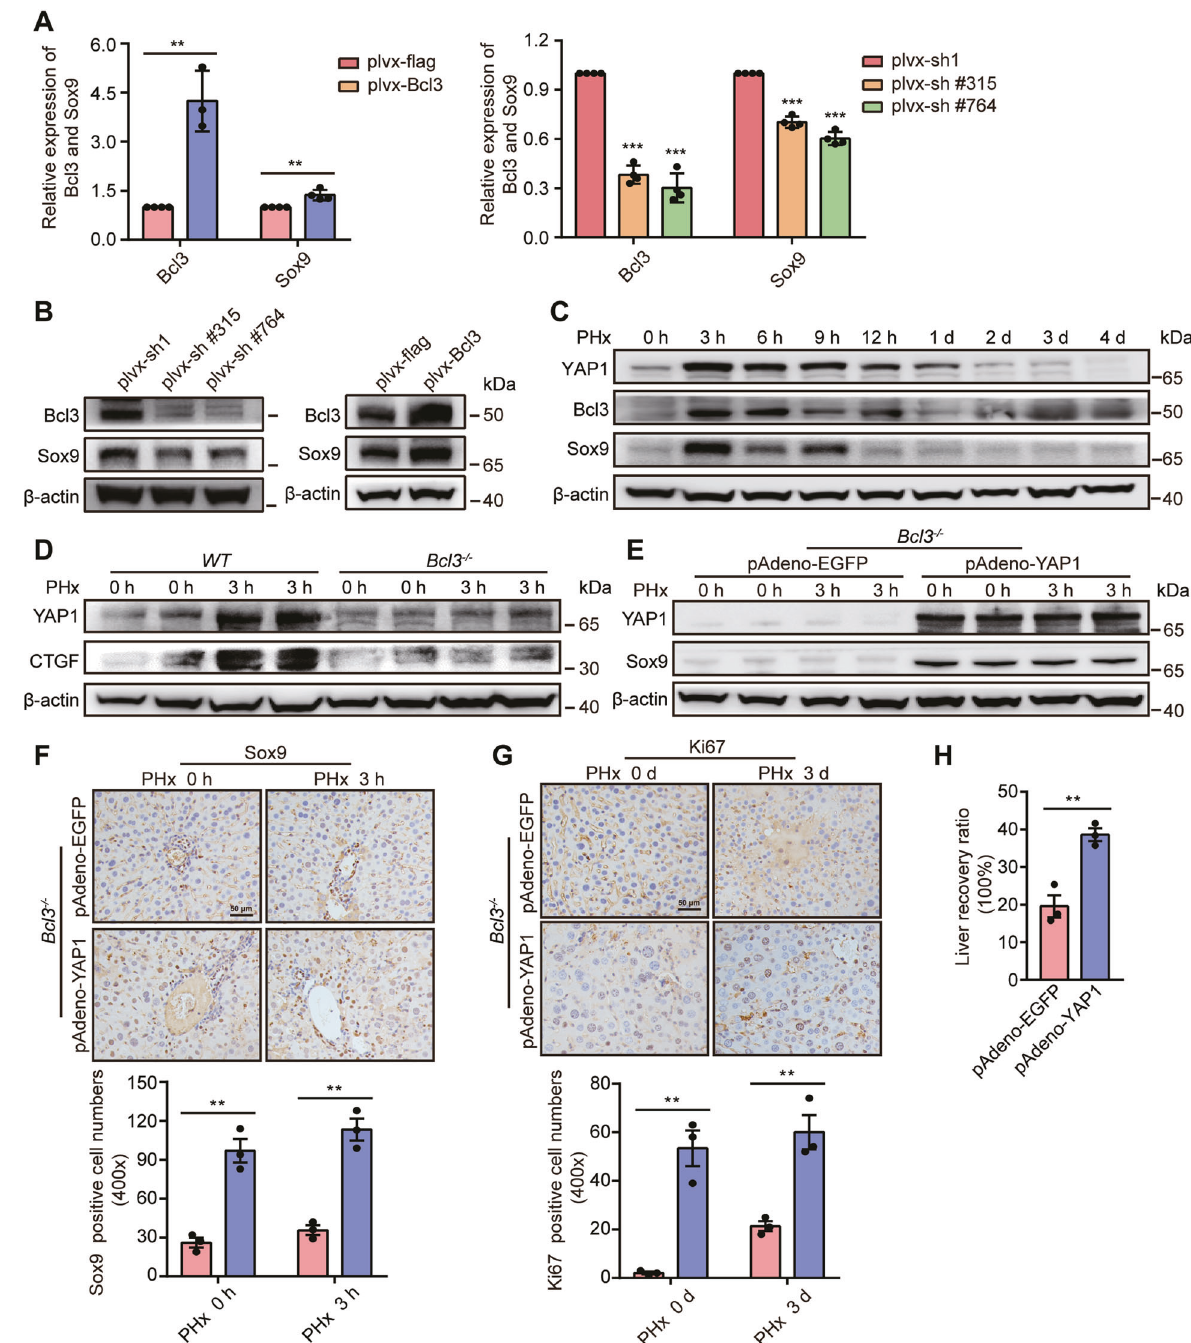
Fig. 4 YAP1 functions as a downstream target of Bcl3 to participate in liver regeneration. A , B qRT-PCR ( A ) and western blotting analysis ( B ) of Bcl3 and Sox9 in AML12 cells after Bcl3 overexpression or silencing. C Representative images showing YAP1, Bcl3, and Sox9 levels, as assessed by western blotting of the liver at the indicated times after PHx. D Representative western blotting analysis of YAP1 and CTGF in wild- type and Bcl3-de fi cient mice at the indicated times after PHx. E The relative expression of YAP1 and Sox9 in Bcl3-de fi cient mice treated with pAdeno-EGFP or pAdeno-YAP1 virus. F , G Representative IHC analysis of Sox9 ( F ) and Ki67 ( G ) in Bcl3-de fi cient mice after YAP1 overexpression. H Liver recovery ratio in Bcl3 − / − mice treated with pAdeno-EGFP or pAdeno-YAP1 virus. The data are expressed as the mean ± SEM. The measurement results were repeated at least 3 times and the results were similar. ** p < 0.01, and *** p < 0.001.